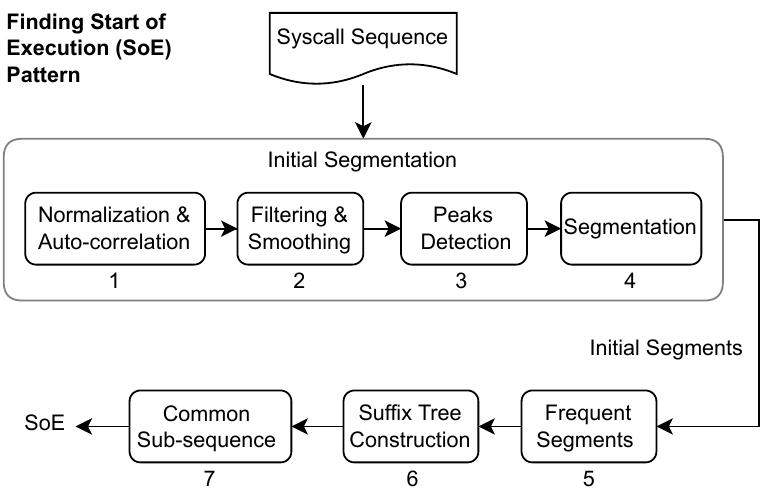
Figure 4. Block diagram showing the process of finding the start of execution pattern: Steps 1 to 4 show the initial segmentation, step 5 uses these initial segments to find the most common segments, step 6 is the construction of the suffix tree, which returns the sub-sequences common among these initial